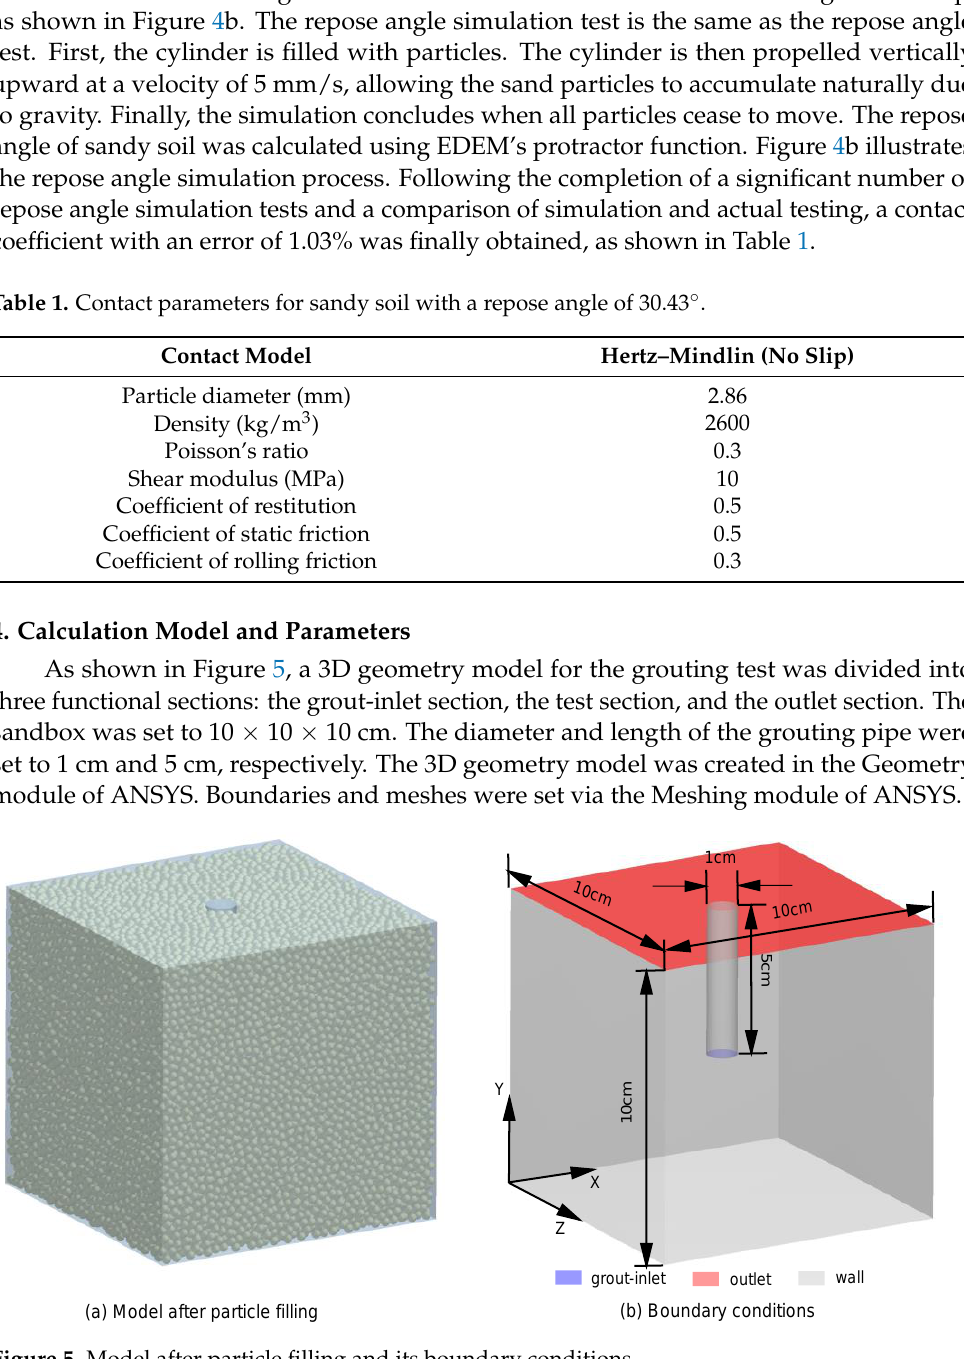
Table 1. Contact parameters for sandy soil with a repose angle of 30.43°.